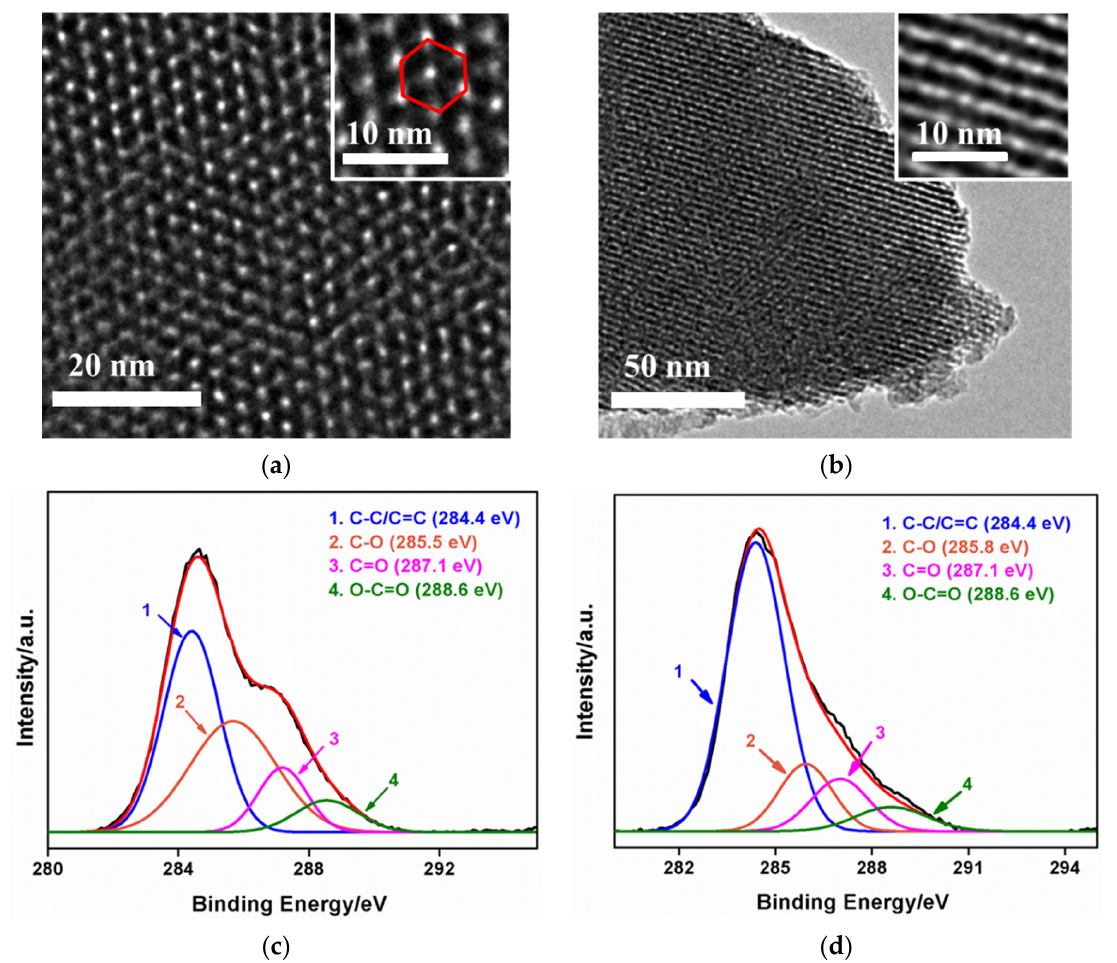
Figure 2. Top-view ( a ) and cross-sectional ( b ) TEM images of NH 2 -VMSF at different magnifica- tions. High-resolution X-ray photoelectron spectrum (XPS) of C1s peaks from GO/SPCE ( c ) and ErGO/SPCE ( d ).